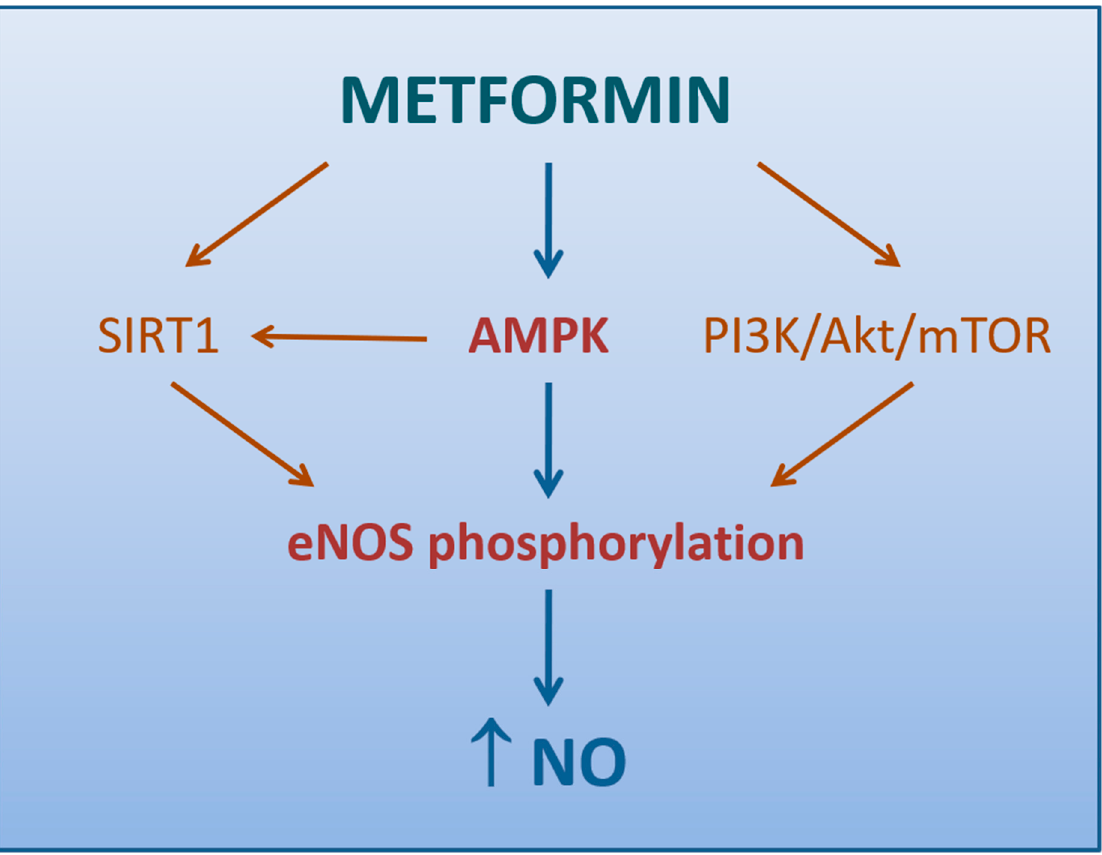
Figure 2. Mechanisms by which metformin promotes NO production (direct arrows indicate the direction of the pathway).